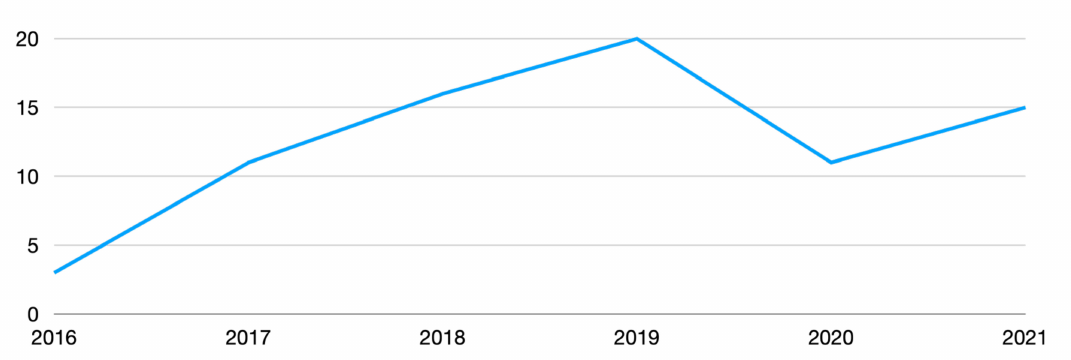
Figure 7. Increase in cases performed by robotic technique during the study period (the decrease in early 2020 is due to the SARS-CoV-2 emergency that led to the cancellation of elective surgeries for a period).